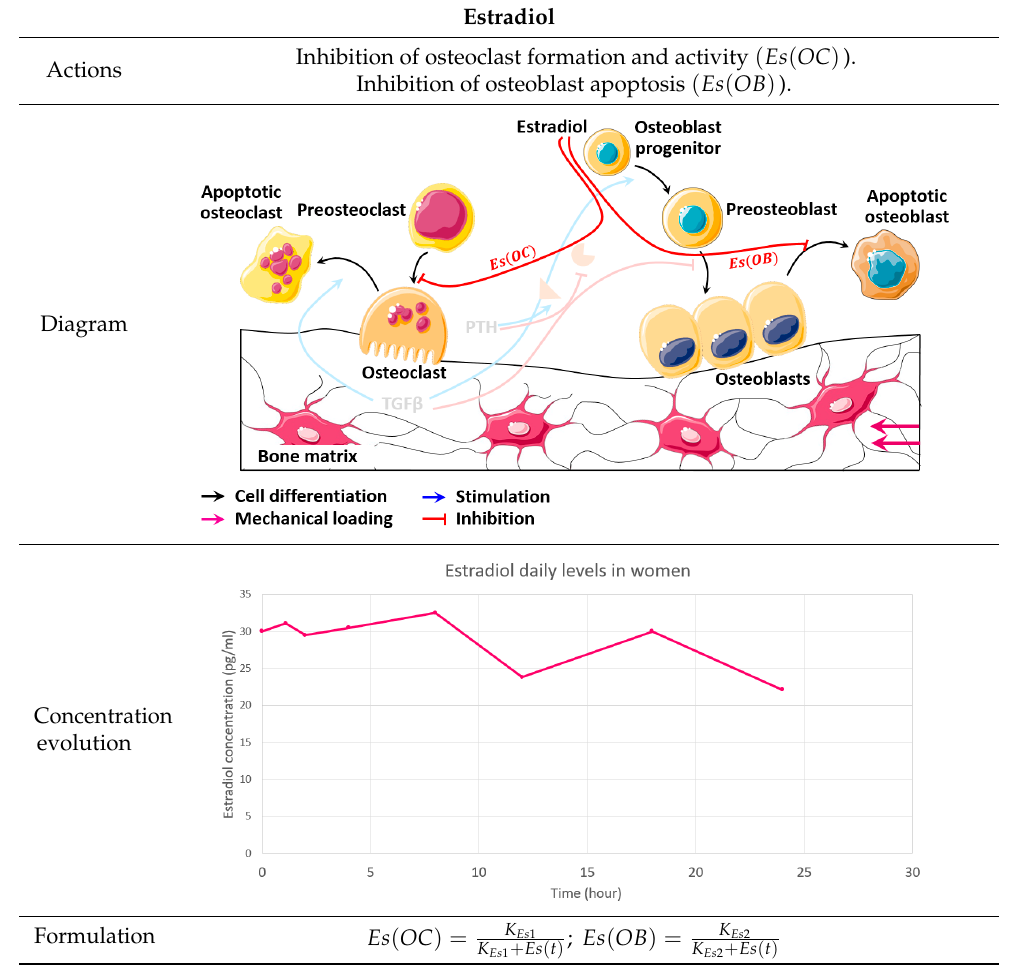
Table 3. Estradiol actions and their mathematical formulation.